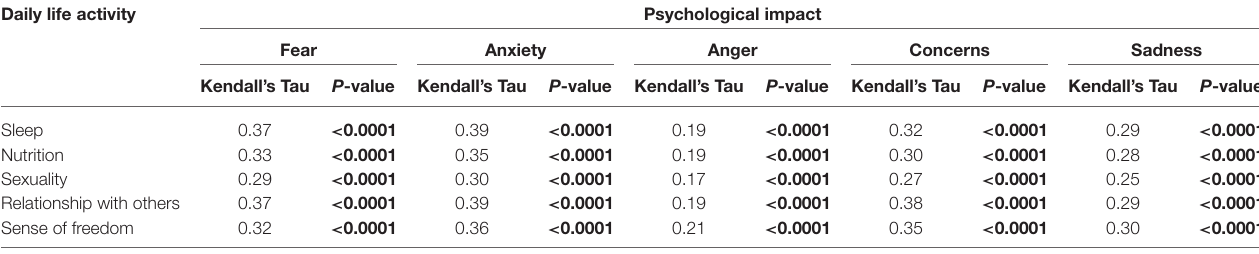
Significant P values are highlighted in bold.